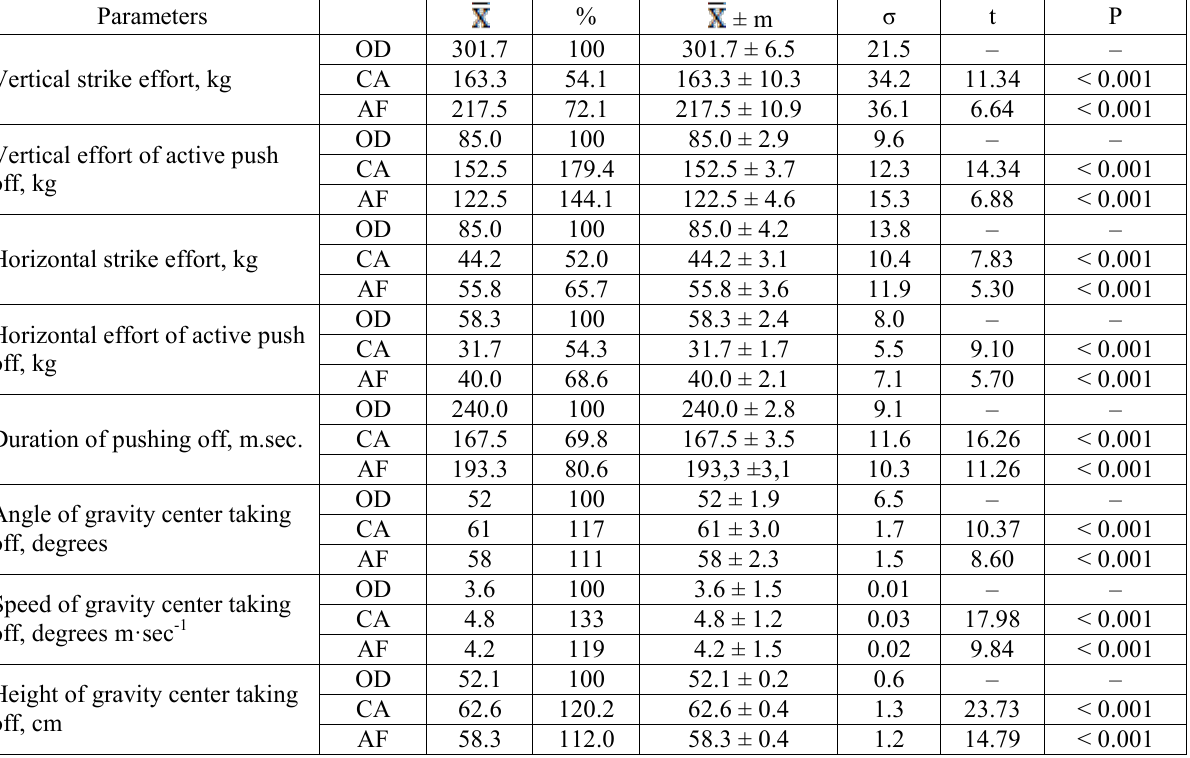
mathematical analysis) n =